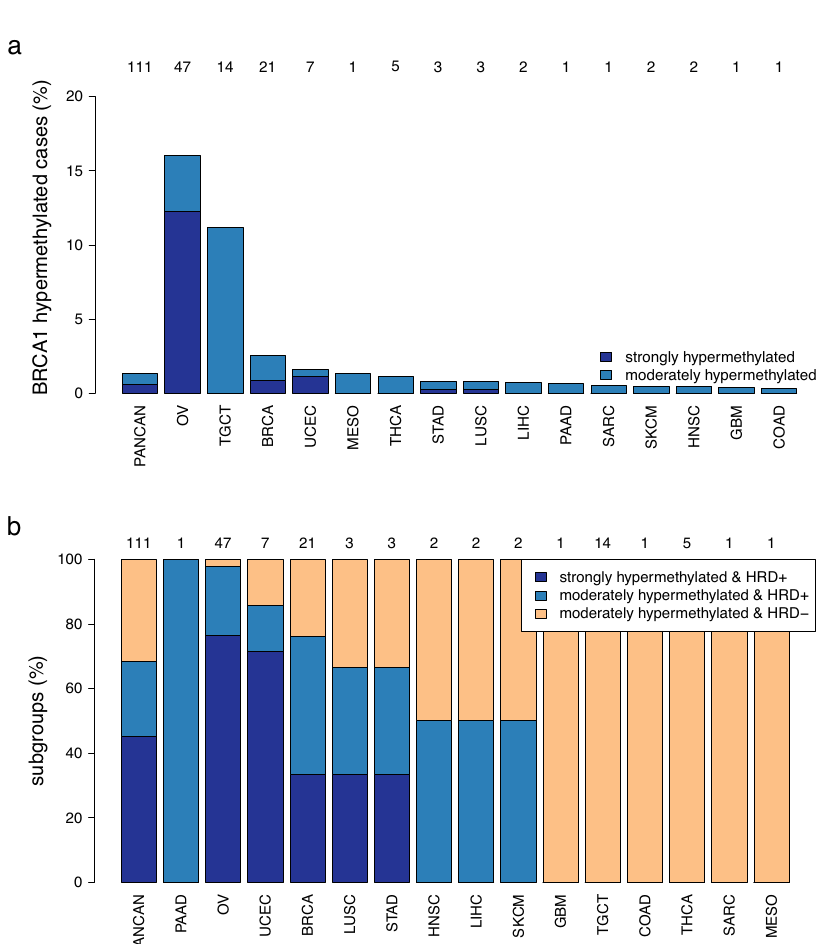
Fig. 4 Analysis of BRCA1 promotor-hypermethylation. a Percentages of strongly and moderately hypermethylated tumors pan-cancer and in speci fi c cancer types. Top line: number of methylated tumors of each cancer type. b Association of methylation status with HRD-positivity (HRDsum ≥ 42). All strongly hypermethylated tumors and 43% of the moderately hypermethylated tumors were